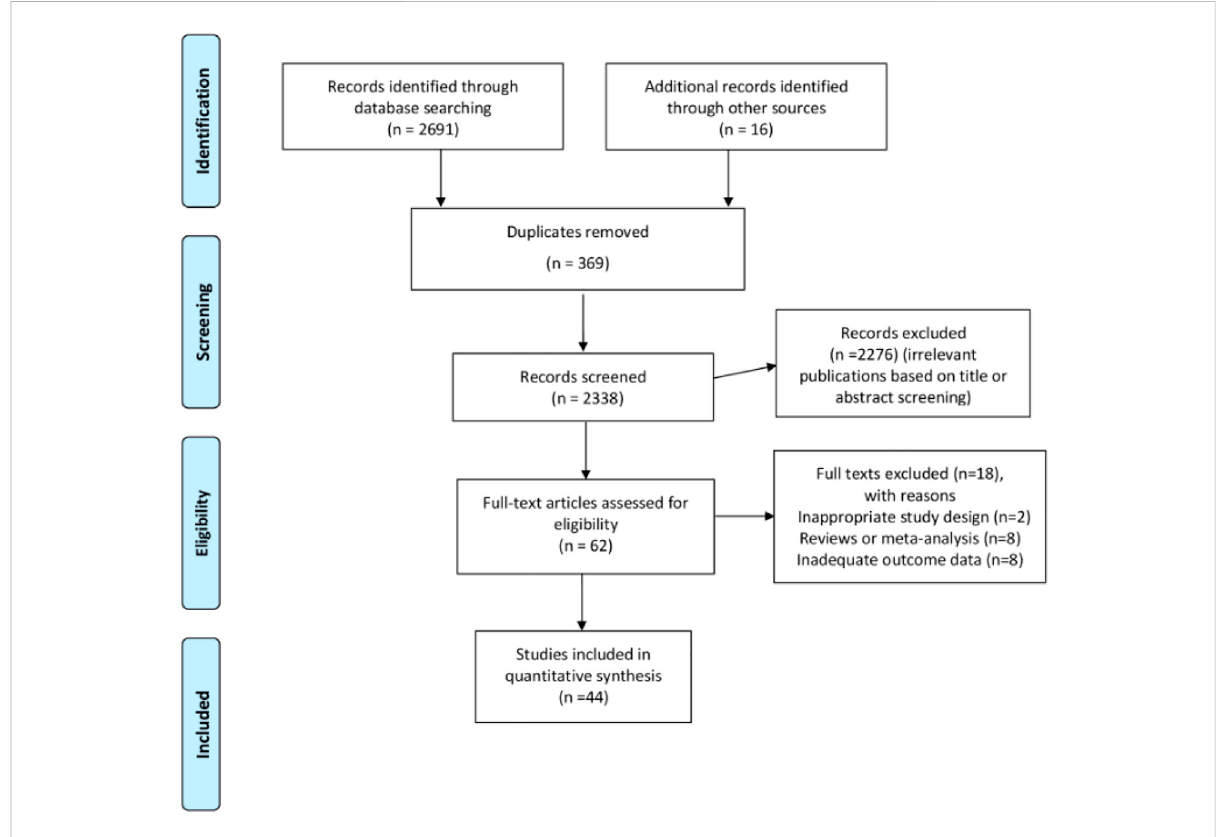
FIGURE 1 Flow diagram of study